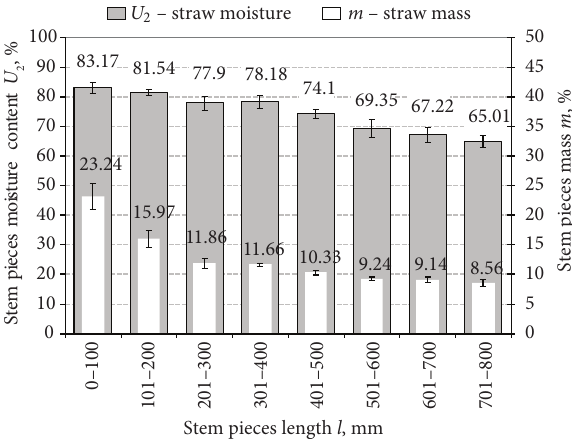
Figure 1. Change in mass ( m 1 ) and moisture content ( U 2 ) of separate 100-mm-long stem pieces of WOSR Catalina